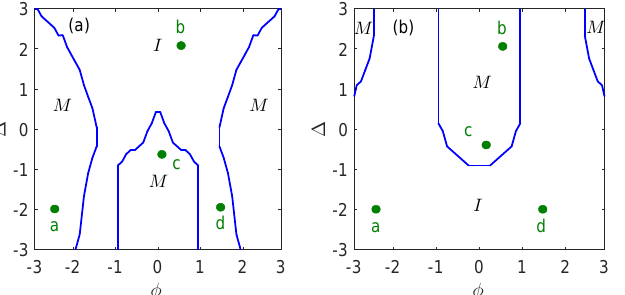
Figure 2. The metal-insulator phase diagrams in the cases of 1/3 filling ( a ) and 2/3 filling ( b ). M refers to the metal phase and I refers to the bulk insulating phase. In each case, there are four chosen typical points, a , b , c , and d , which are marked by green dots and are discussed in the main